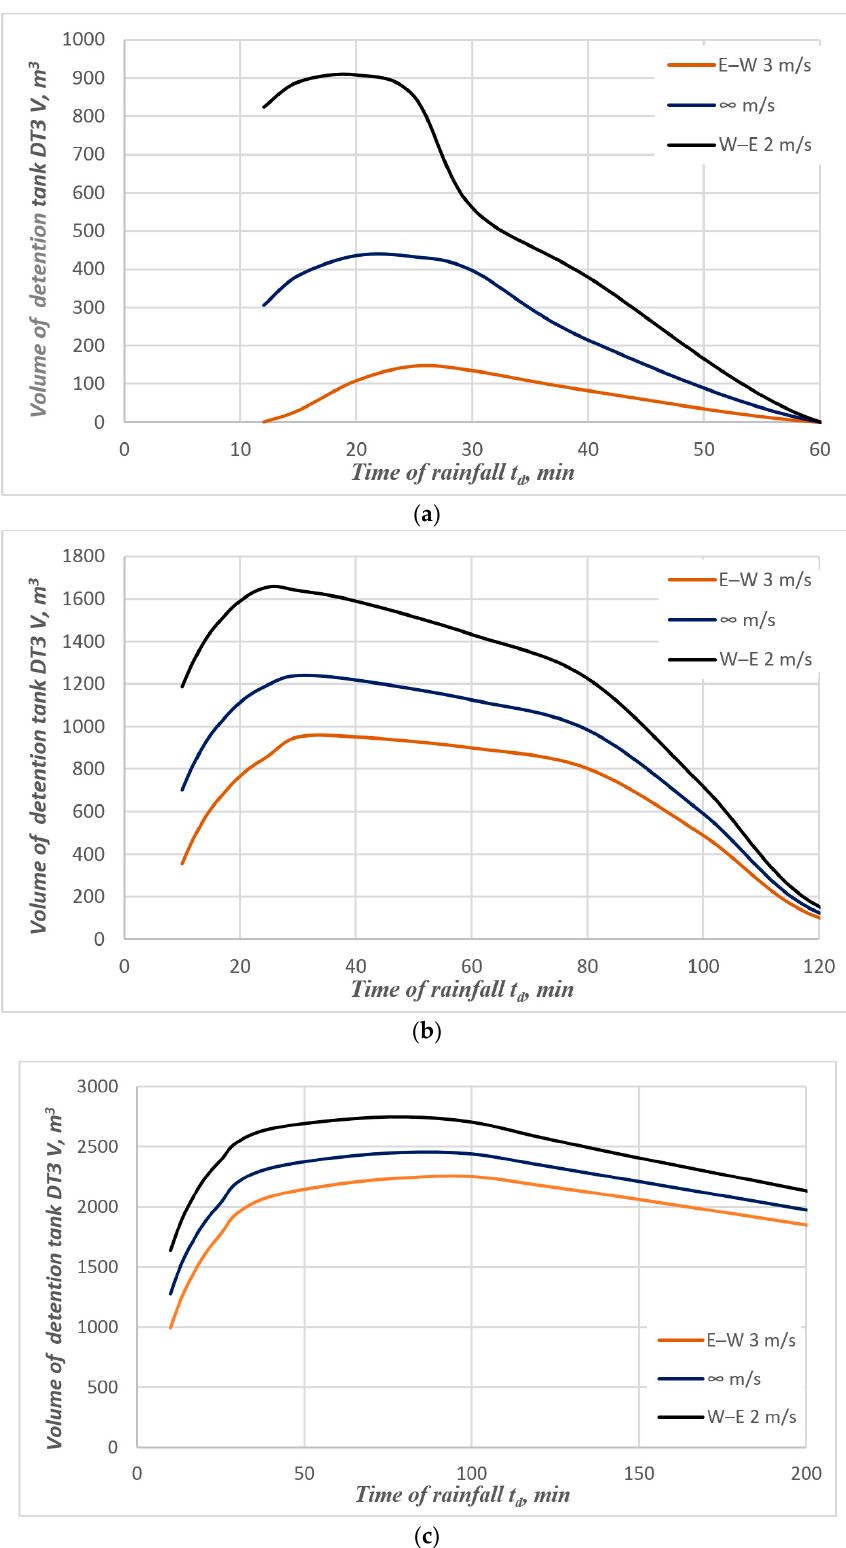
Figure 6. Curves defining the required volume of detention tank DT3 at the specific diameter of the outflow channels from tanks DT1 and DT2 with Do = 0.3 m and outflow channel from reservoir DT3 : ( a ) Do = 0.8 m, ( b ) Do = 0.65 m, and ( c ) Do = 0.5 m. The movement of the wave of rainfall over the catchment changes the shape of the hydrograph illustrating the stormwater flow rate Q A in the stormwater drainage system over time (Figure 5). Because the required volume of the detention tanks is determined on the basis of the balance affects the estimated required tank volume.